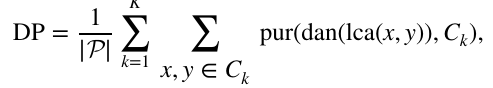
Fig. 5 The plots show a sample of original MNIST digits and a ran- domly augmented